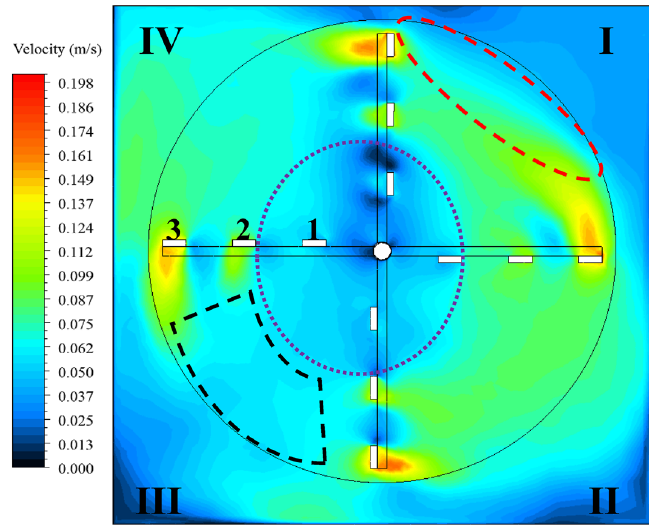
Figure 7. Close inspection of velocity contour generated using IDDES at 3